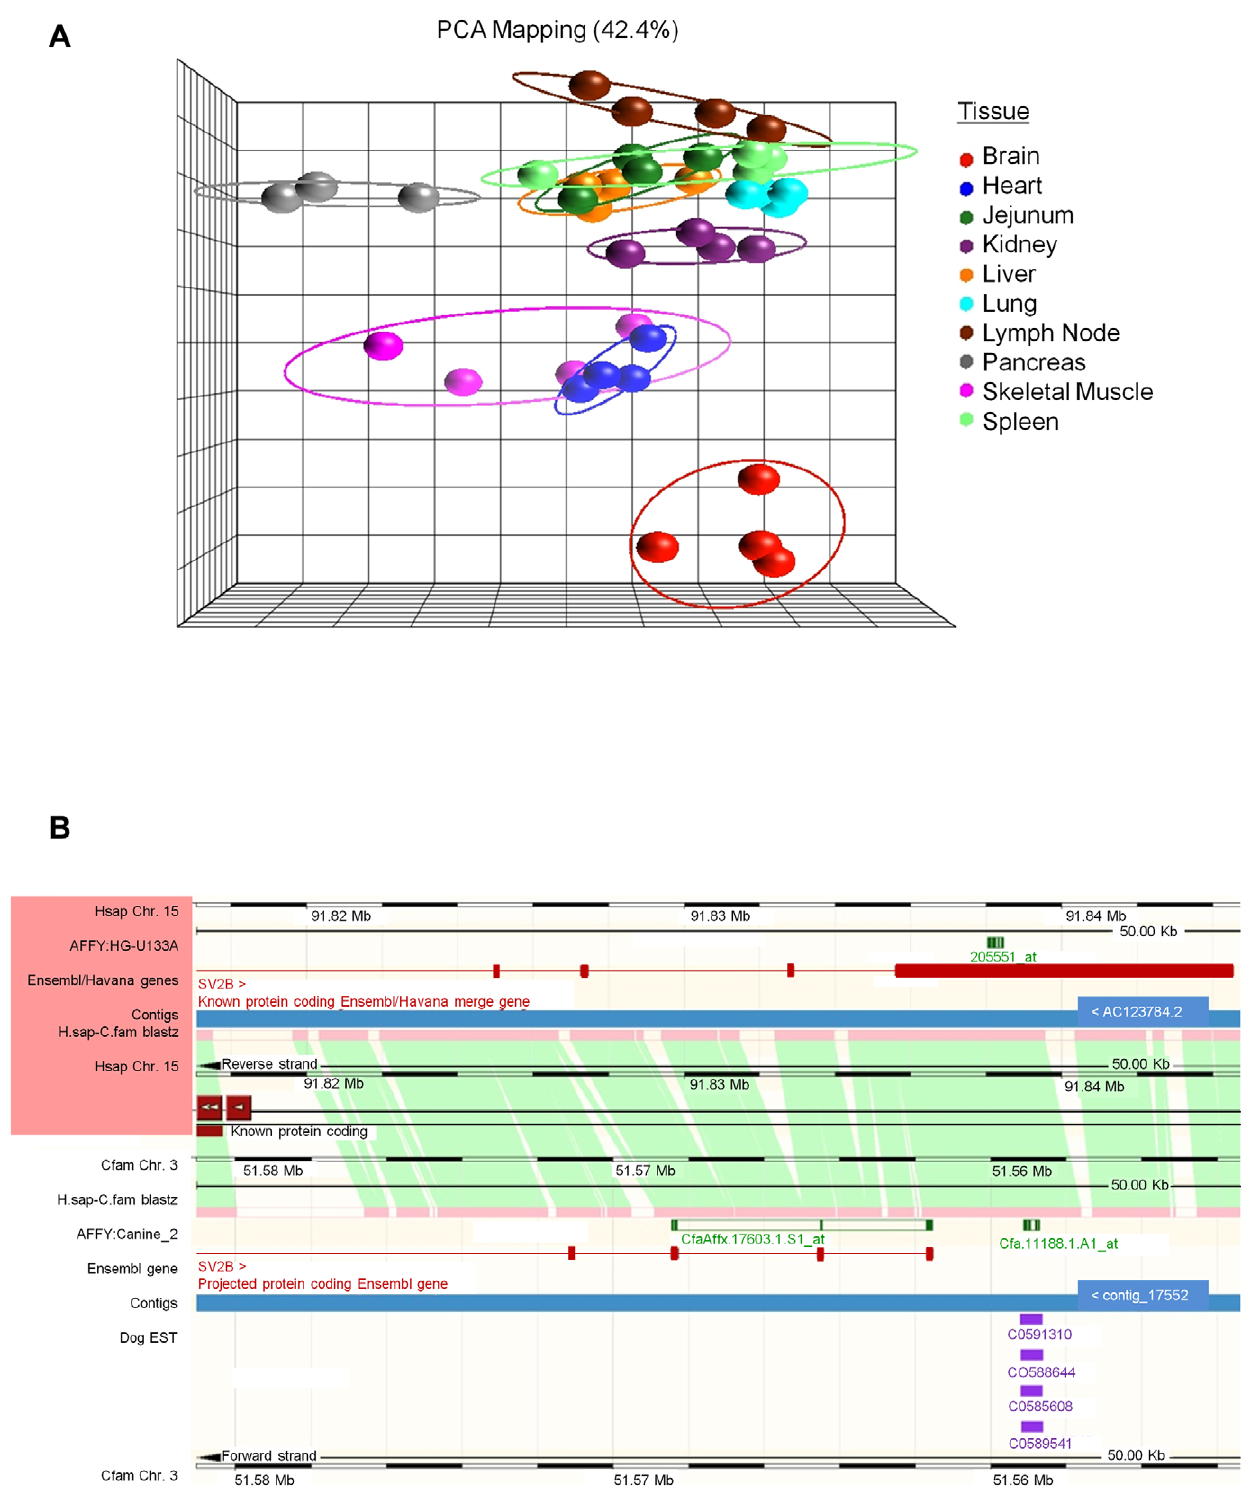
Figure 3. Resolution of transcript assignment for canine probesets mapping to the SV2B gene locus. A . Principle component analysis of all 11,339 canine probesets with no gene identifier associated. B . Ensembl BLASTZ pairwise genomic alignment of human chromosome 15 (top panel) and canine chromosome 3 (bottom panel) centered on the 3 9 region of the SV2B gene locus. Affymetrix human U133A probeset, 205551_at (SV2B), and canine_2 probesets, CfaAffx.17603.1.S1_at (SV2B) and Cfa.11188.1.A1_at (unidentified) are aligned to their corresponding genomic regions. Canine EST evidence is shown in purple.